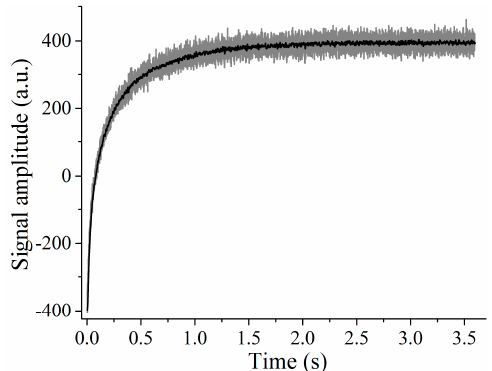
Figure 11. Original (gray) and denoised (black) continuous wave free precession (CWFP- T 1 ) signals using a second-order Savitzky–Golay filter with 41-data-point windows of a MnSO 4 aqueous solution. The signal to noise ratio (SNR) of the original and smoothed data signals are 39 and 374, respectively.